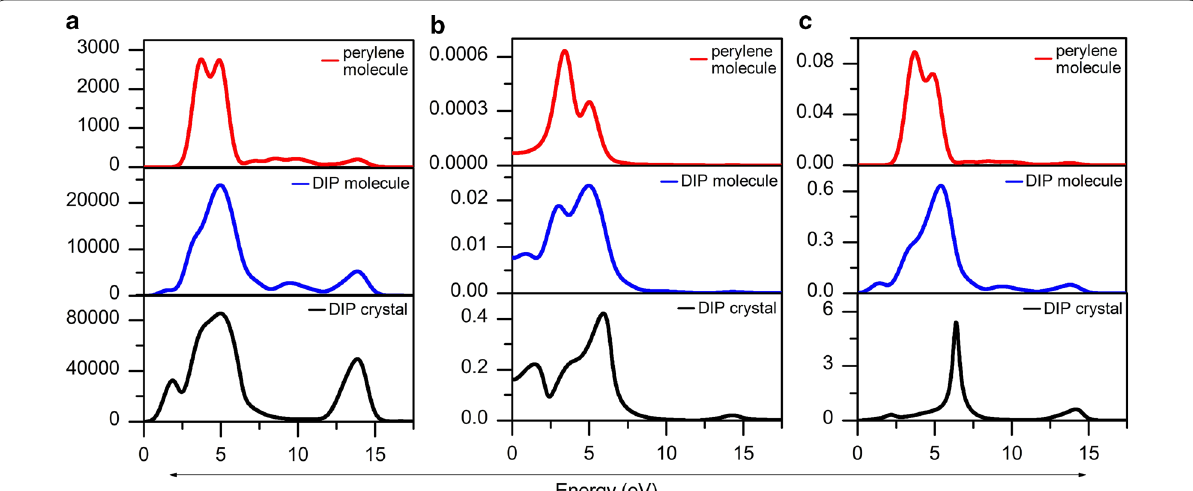
Fig. 6 a Absorption, b reflectivity and c loss function spectra of perylene molecule (red spectra), DIP molecule (blue spectra) and DIP crystal (black